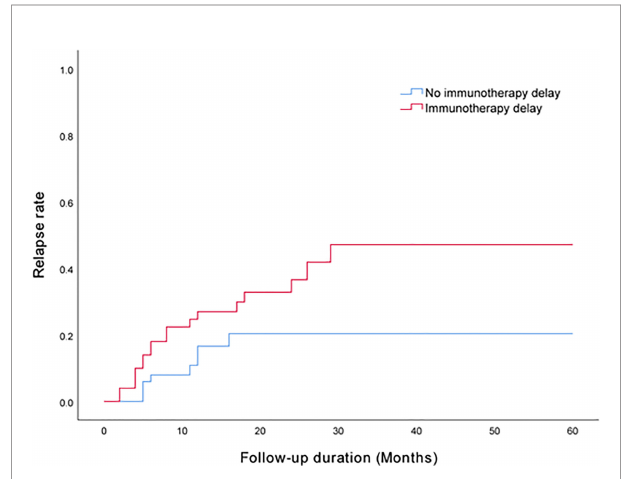
FIGURE 1 | Kaplan - Meier curve shows that immunotherapy delay was associated with an increased risk of